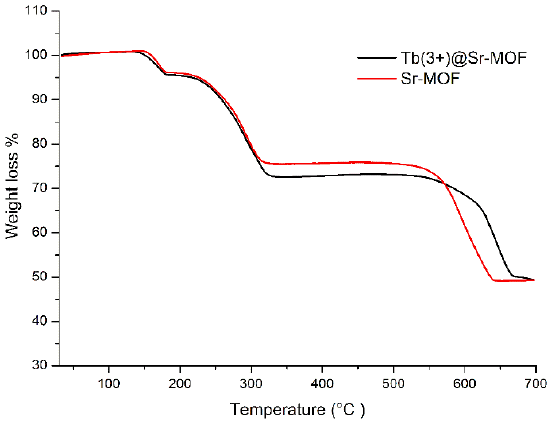
Figure 3. TGA of Sr-MOF and Tb(3+)@Sr-MOF.